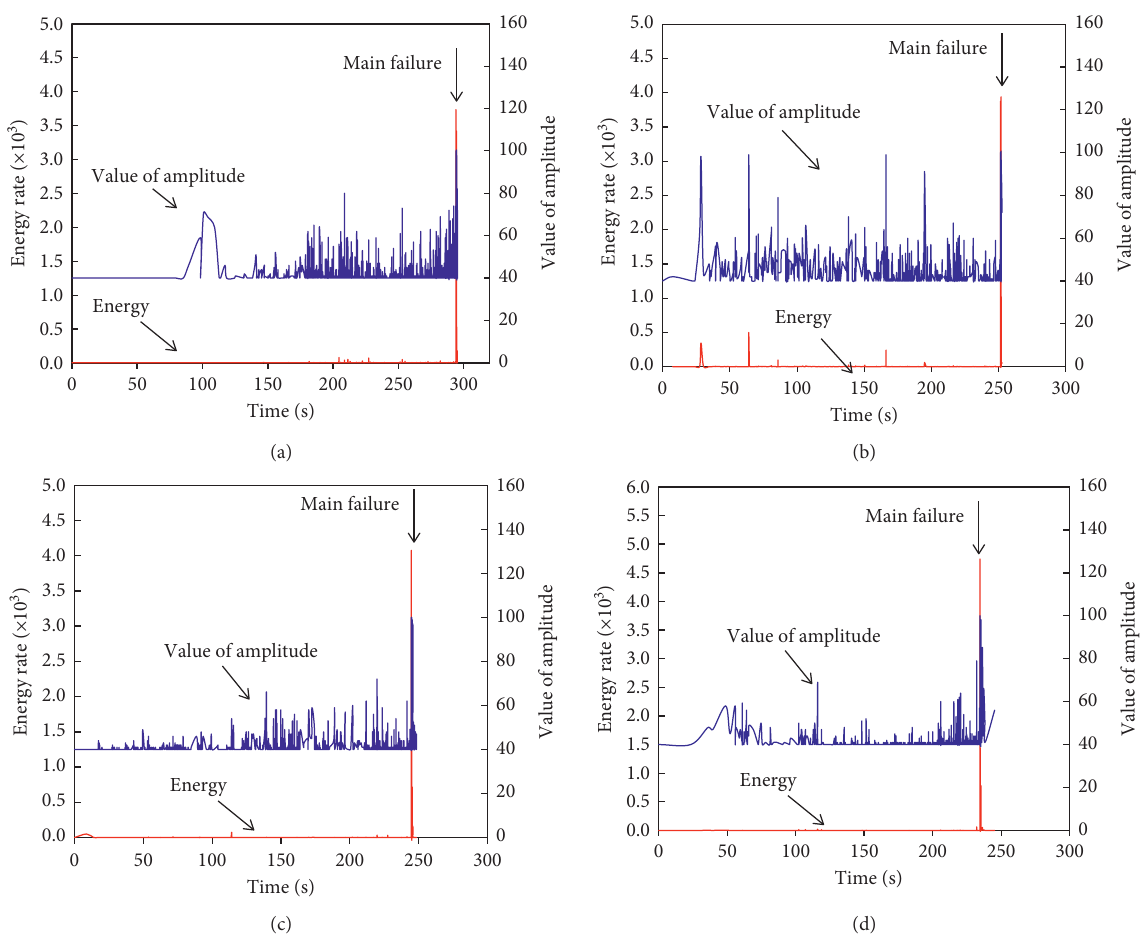
Figure 8: Acoustic emission characteristics and strain field of AI before the samples were broken and analysed by DIC. (a) B-2. (b) B-3. (c) B-4. (d) B-5.